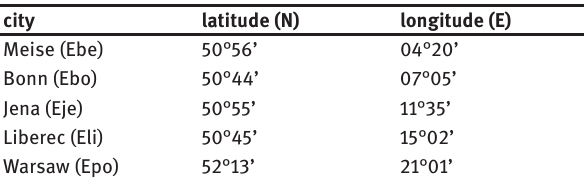
Table 1: Coordinates of botanical gardens where samples were